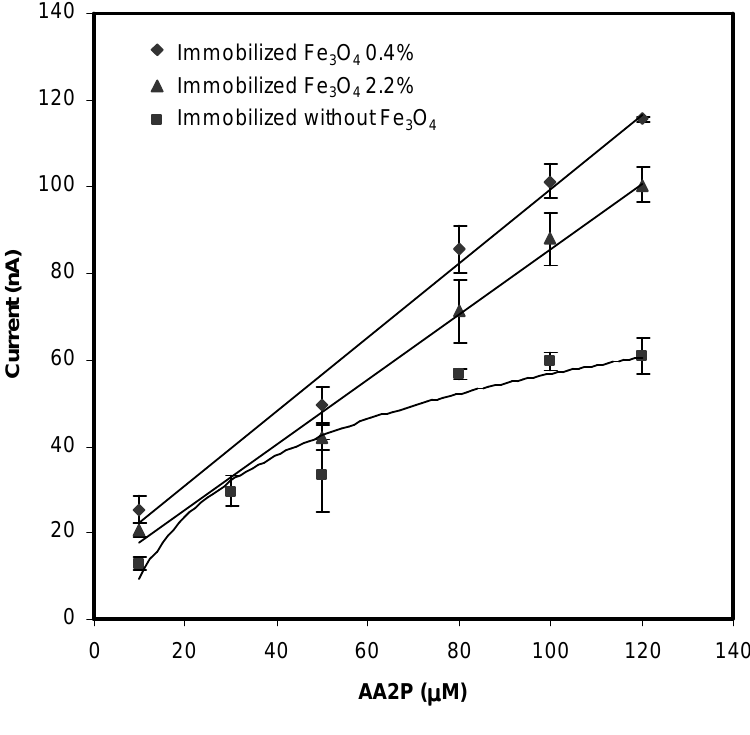
Figure 4. The response of biosensors with immobilized Fe without Fe O in the presence of changing concentrations of AA2P 3 4